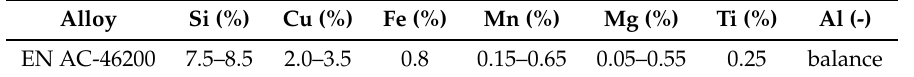
Table 1. Nominal chemical composition of the investigated cast alloy EN AC-46200 in weight percent.